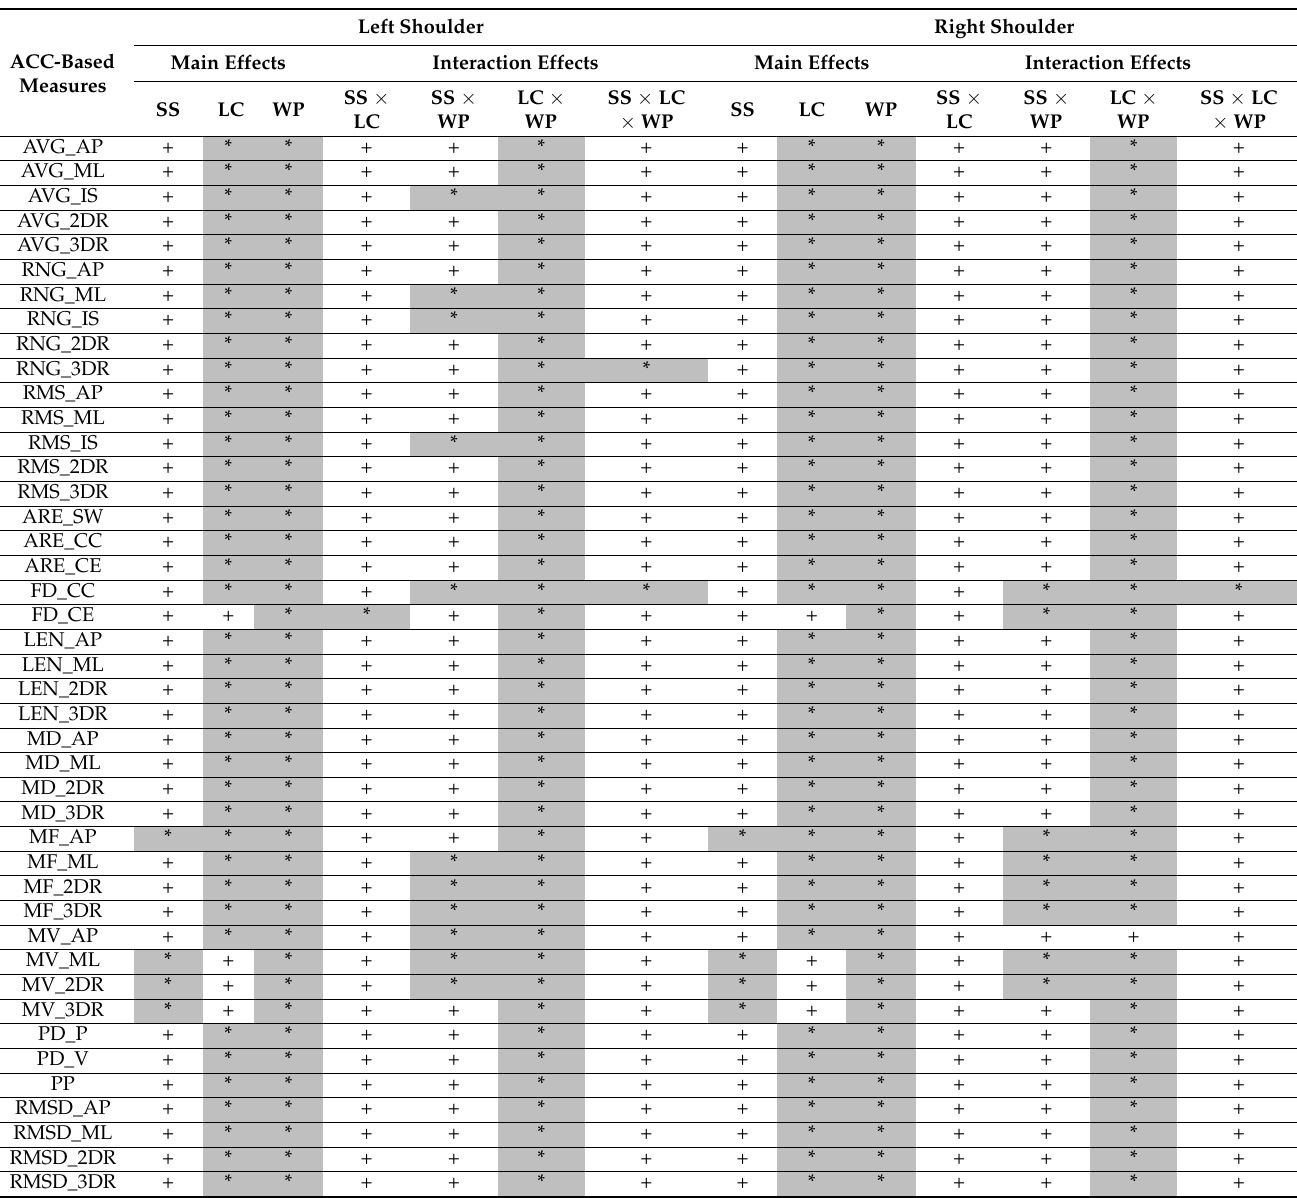
Table A2. Results 1 of t -tests and Analysis of variance using the acceleration data of